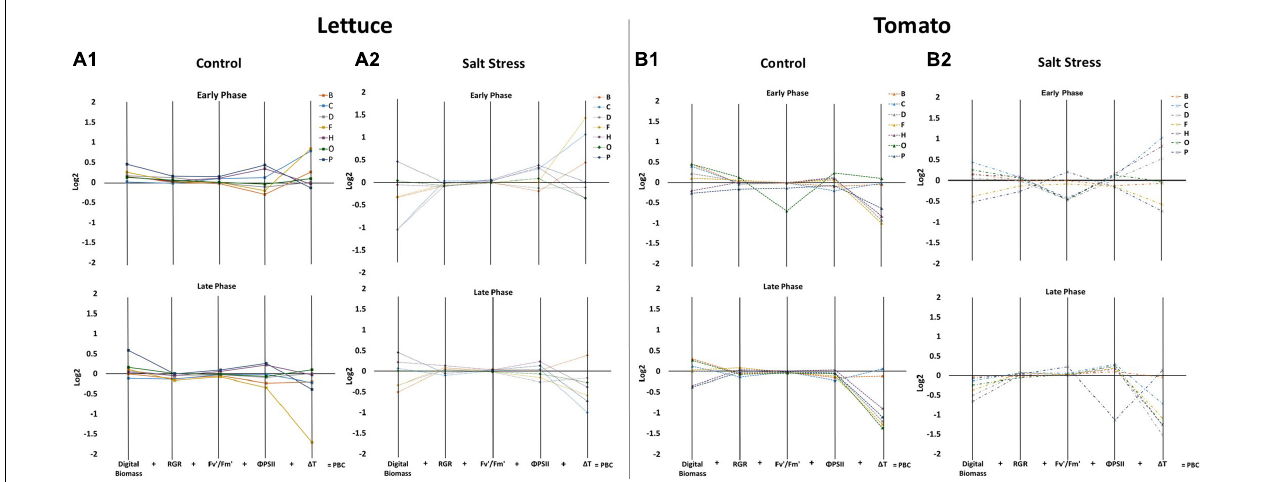
FIGURE 3 | Characterisation of the effect of biostimulants on the performance of tomato and lettuce plants grown under control and salinity conditions. Parallel coordinate plots of the 5 main morpho-physiological parameters (Digital Biomass, RGR, Fv (cid:48) /Fm (cid:48) , (cid:56) PSII and (cid:52) T) are shown for lettuce plants grown in control [full lines, (A1) ] and salt stress conditions [dotted lines, (A2) ], for tomato plants grown in control [dashed lines, (B1) ], and salt stress conditions [dotted and dashed lines, (B2) ]. The values represent the log2 of the ratio between the plants treated with the 7 protein hydrolysates (PHs) and their respective controls, the sum of the resulting 5 values corresponds to the Plant Biostimulant Characterisation (PBC) index, used for the characterisation of the PHs. Data are shown for the early (0–12 Days of Phenotyping) and the late phase (12–21 Days of Phenotyping) of the plant